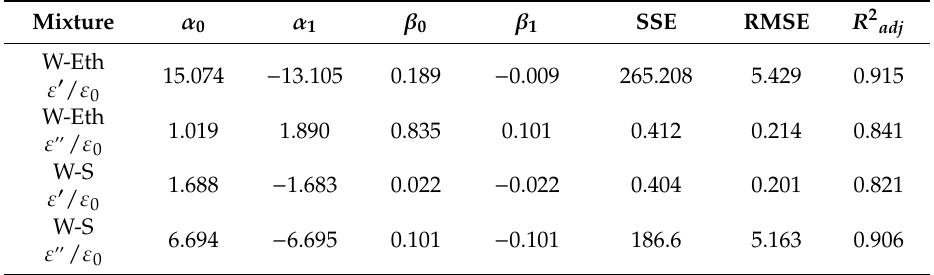
Table 2. Values of the model parameters and the statistical indicators regarding the regression carried out with the King and Queen model; the superscript k indicates which part of the permittivity (real or imaginary) the parameter represents while the subscript i or j specify the pure component